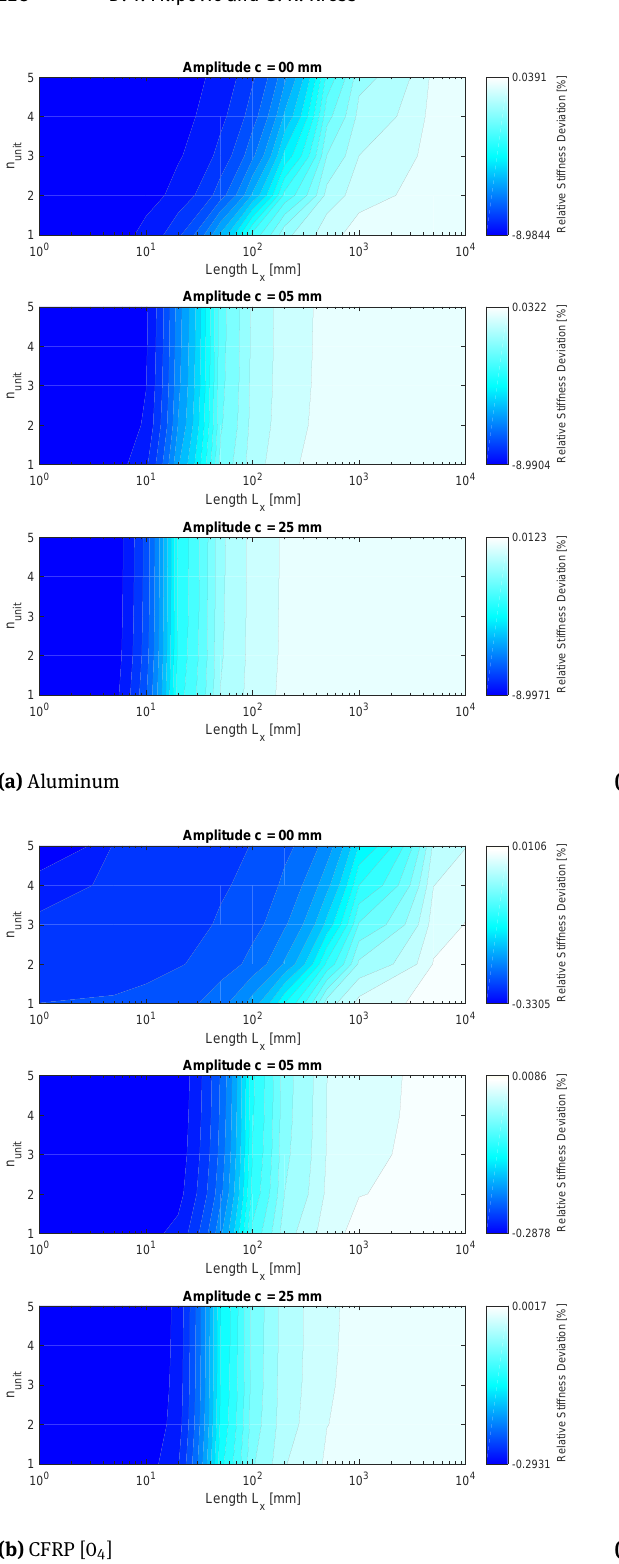
Figure 20: Load case 5 normalized apparent stiffnesses versus L x and n unit - for CFRP [90 4 ] and CFRP [±45]